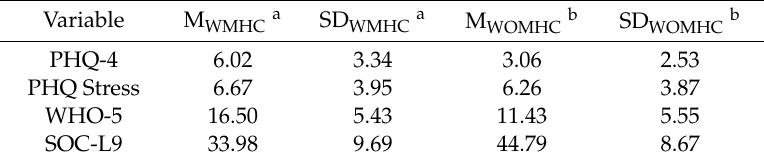
Table 3. Means and standard deviations for PHQ-4, WHO-5, SOC-L9, and PHQ stress module for participants with (WMHC) and without (WOMHC) pre-existing mental health conditions.